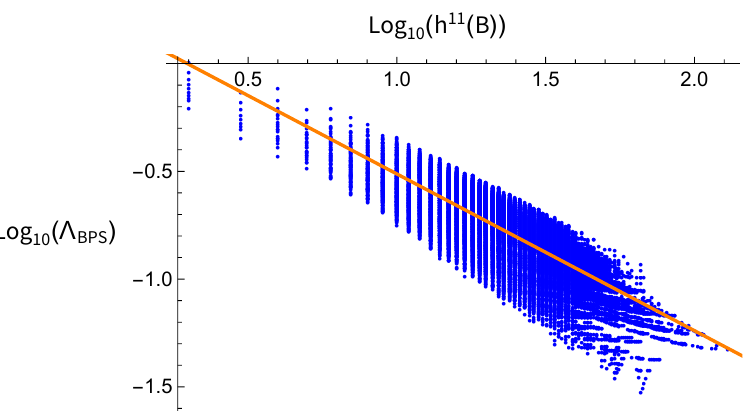
Figure 2 . Logarithmic plot of the minimal gap obtained from equation (5.1) versus h 11 ( B ) , for the 34868 toric bases in the toric mini-Landscape described in [30]. There is some spread corresponding to different models with the same h 11 ( B ) , but there is an overall linear trend, with the best fit shown, corresponding to the function h 11 ( B ) − n with n ∼ 0 . 7